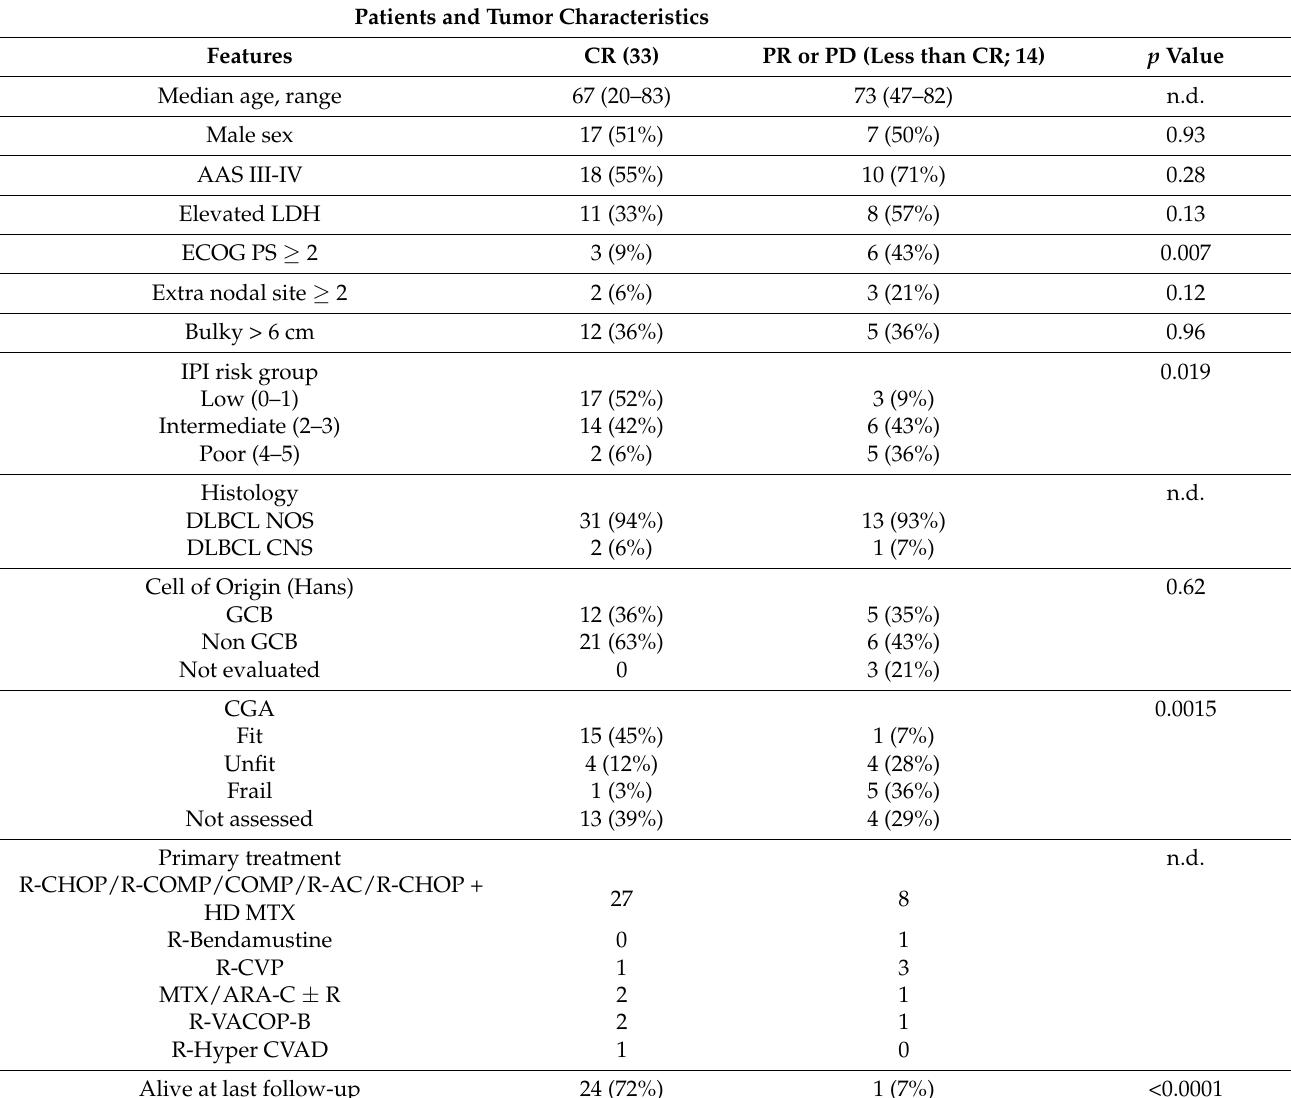
Table 1. Clinical characteristics of evaluated